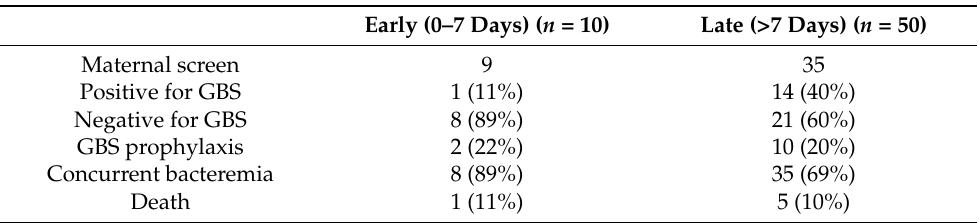
Figure 2. Enteroviral meningitis by year. Table 3. Characteristics of cases of group B Streptococcus ( n = 60) meningitis among infants 0 to 90 days old, by age at presentation, Houston